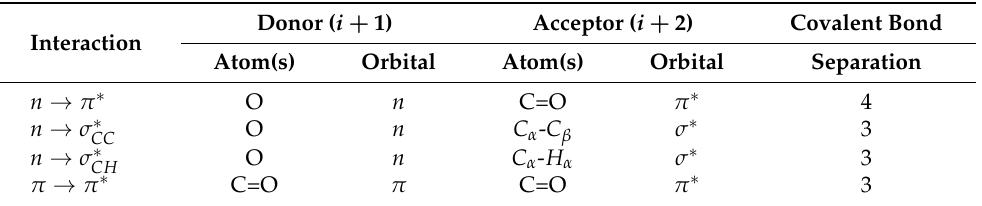
Table 1. Description of donor and acceptor orbitals of i + 1- i + 2 overlap interactions found in a β